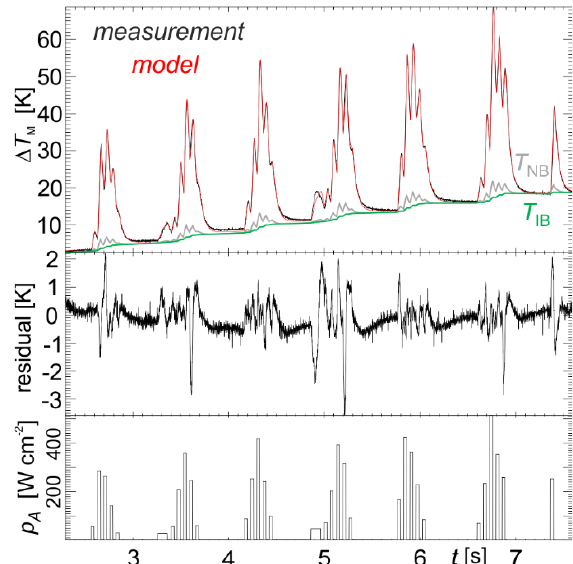
Fig. 13. Evaluation of thermocouple measurement, AUG #39747 showing in the top row: measurement (black) and the temperature at the model grid points T M (red), T NB (grey), T IB (green). The amplitudes of the model temperature T SM are much larger and not shown for simplicity. Second row: residual = model temperature minus measurement. The residual is subject to minimization in the fit procedure using the p A as fit parameters. The resulting p A are shown in the bottom row. The parameter r IB was also fitted, but assumed constant during the experiment.